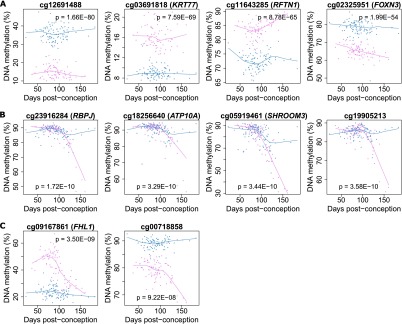
Sex-specific DNA methylation differences in the developing fetal brain. A total of 8059 (1.99% of the 408,594 autosomal and X-linked probes assessed) were identified as significantly differentially methylated between males and females in the fetal brain, with most differences occurring on the X Chromosome as expected. However, a number of autosomal loci also show significant differences between males and females, as illustrated by the four probes shown in A. Of note, DNA methylation at a number of (B) autosomal and (C) X Chromosome probes showed significant interactions between sex and developmental stage, indicating differential trajectories of DNA methylation in the developing male and female brain.